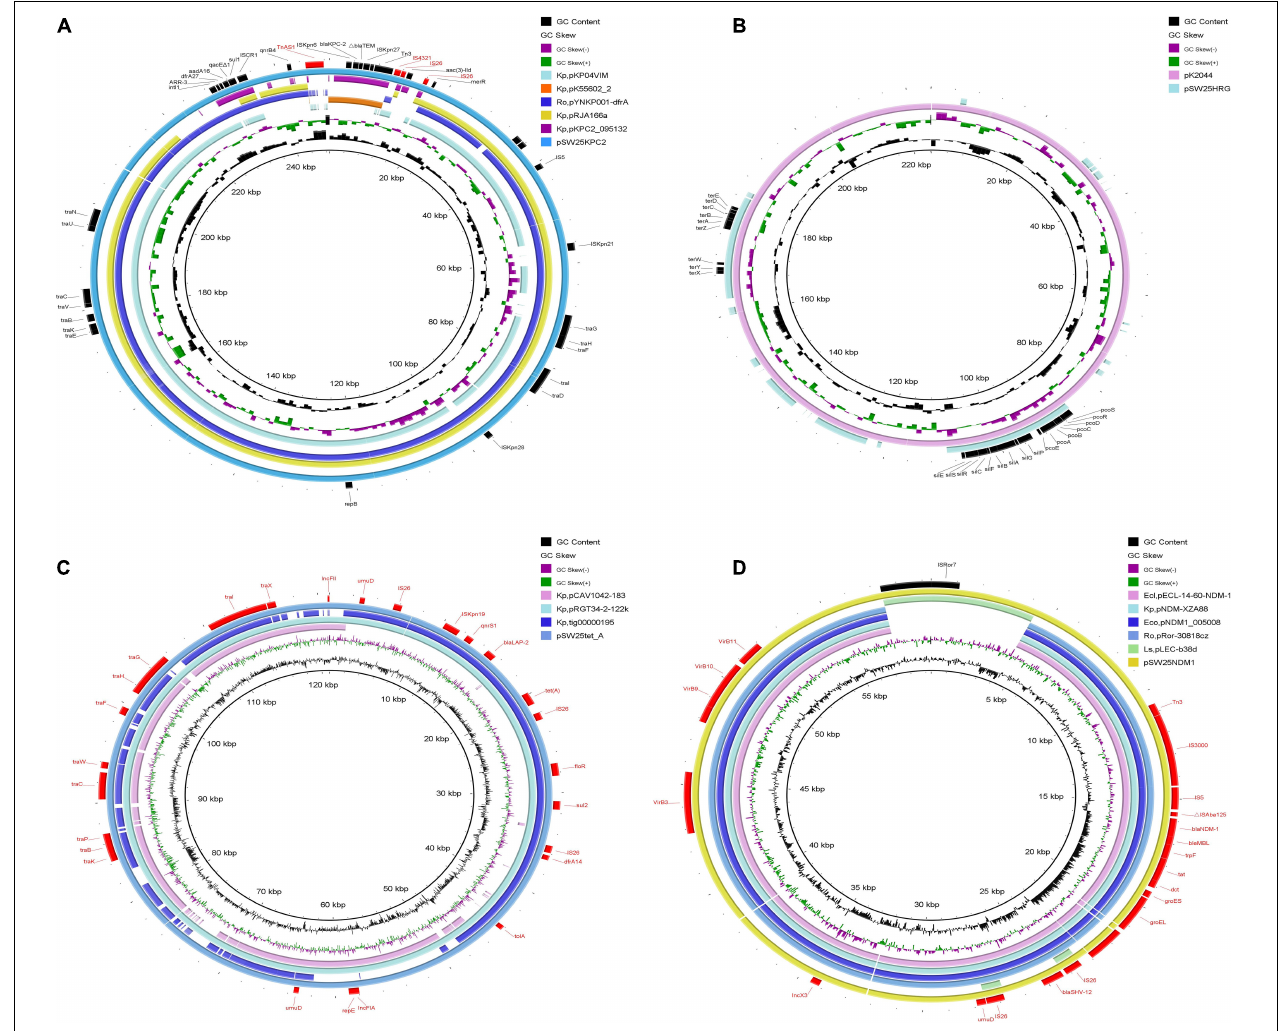
FIGURE 3 | Comparative genomic circle of plasmids. (A) Circular comparison of pSW25KPC2 with other similar plasmids, pSW25KPC2 was used as a reference. (B) Circular comparison between pSW25HRG and virulence plasmid pK2044, pK2044 was used as a reference. (C) Circular comparison of pSW25tet_A with other similar plasmids, pSW25tet_A was used as a reference. (D) Circular comparison of pSW25NDM1 with other similar plasmids, pSW25NDM1 was used as a reference. The outermost circle annotates the genetic information, and different plasmids are assigned different colors. Blanks represent deleted regions compared to the reference plasmids. Kp: K. pneumoniae , Ro: R. ornithinolytica , Ecl: E. cloacae , Eco: E. coli , Ls: Leclercia